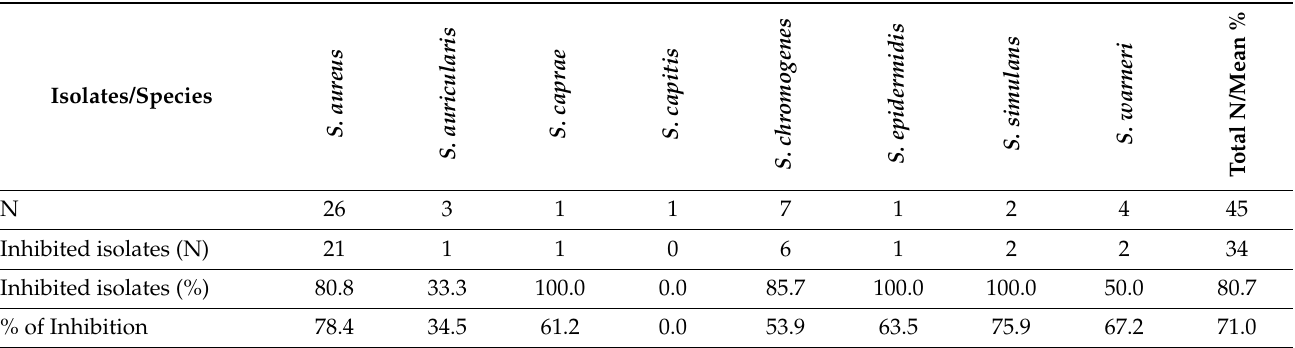
Table 3. Propolis inhibition of biofilm formation: number and respective percentage of isolates and mean inhibition percentage.